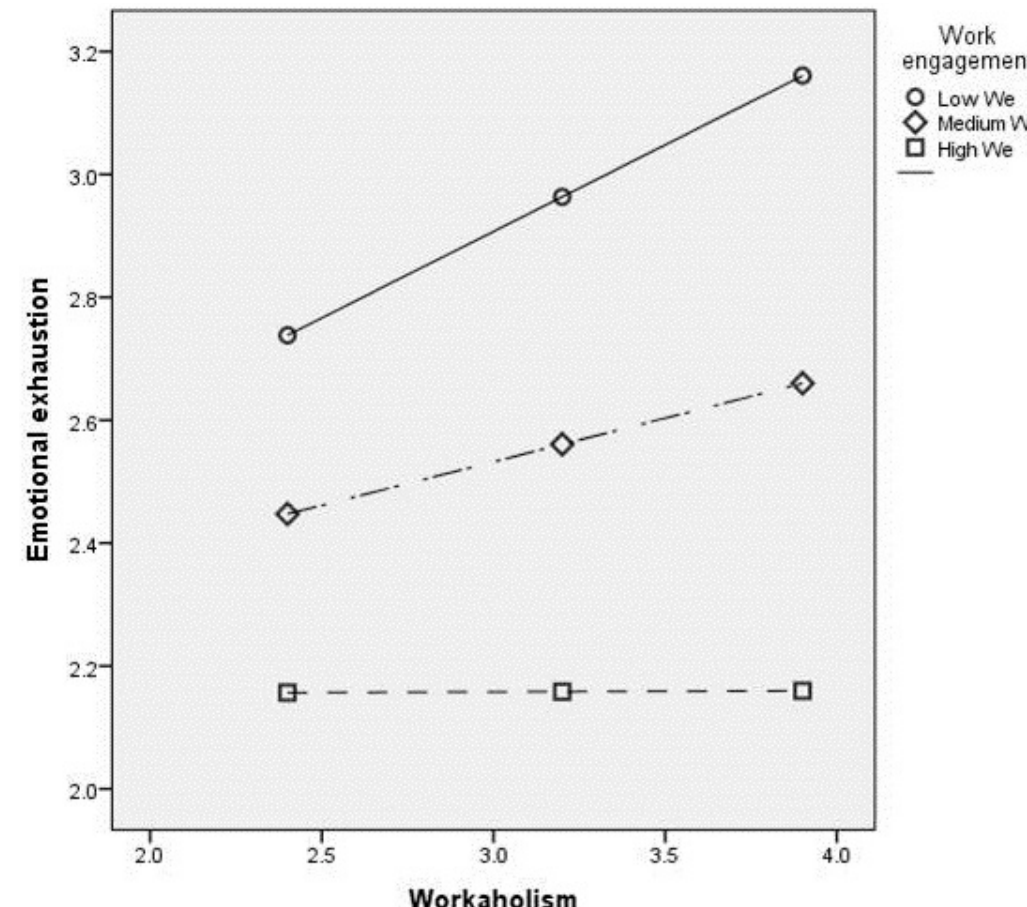
Figure 3. Plot of the interaction between workaholism and emotional exhaustion, moderated by work engagement.